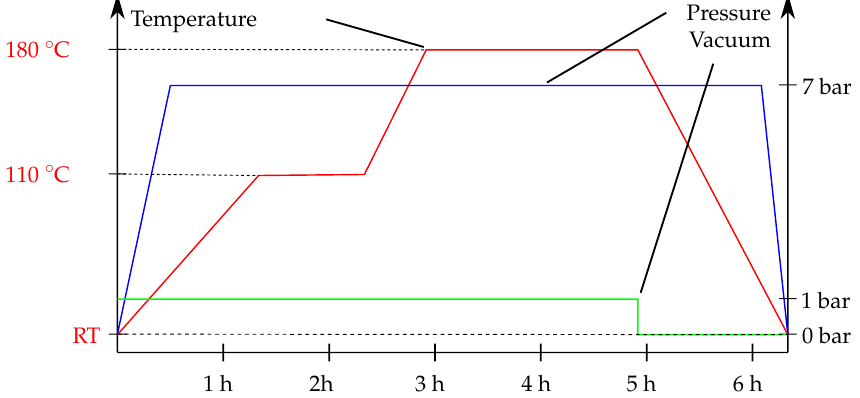
Figure 2. Autoclave curing cycle for all laminates in this